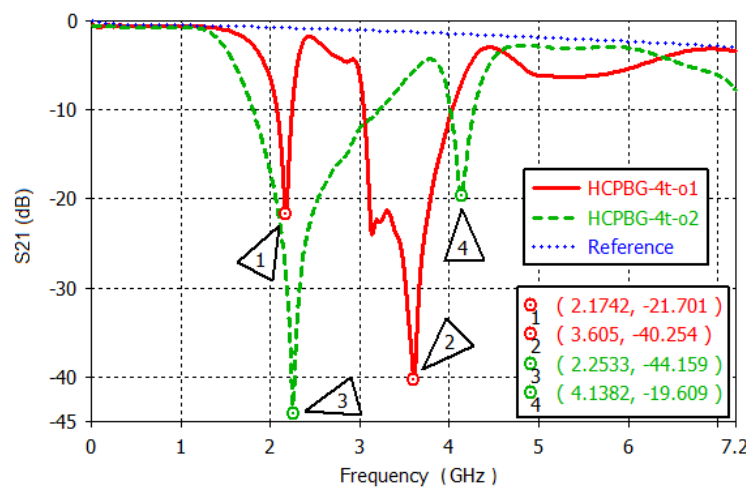
Figure 4. Simulation—transmission loss for HCPBG with 4 traces—orientations o1 and o2. We also simulated HCPBG with three traces and six traces, keeping the same dimen- sions to verify the attenuation band profile’s behavior. Figure 5 shows the transmission loss for the HCPBG with 3 traces and two different orientations, as indicated in Table 1 by cases (a) and (b). Both have similar filtering profiles up to 4.5 GHz, with a first attenuation around 2 GHz, and with BW of 645 MHz for HCPBG-3t-01 and BW of 380 MHz HCPBG-3t-o2. The second attenuation band is close to 3 GHz for both. The main difference is that HCPBG- 3t-o1 produces a third strong wideband attenuation at 5.75 MHz (BW = 1670 MHz). The LC network seen by the microstrip line depends on the HCPBG orientation, and it seems to have more impact when the HCPBG traces are more aligned with the microstrip line.